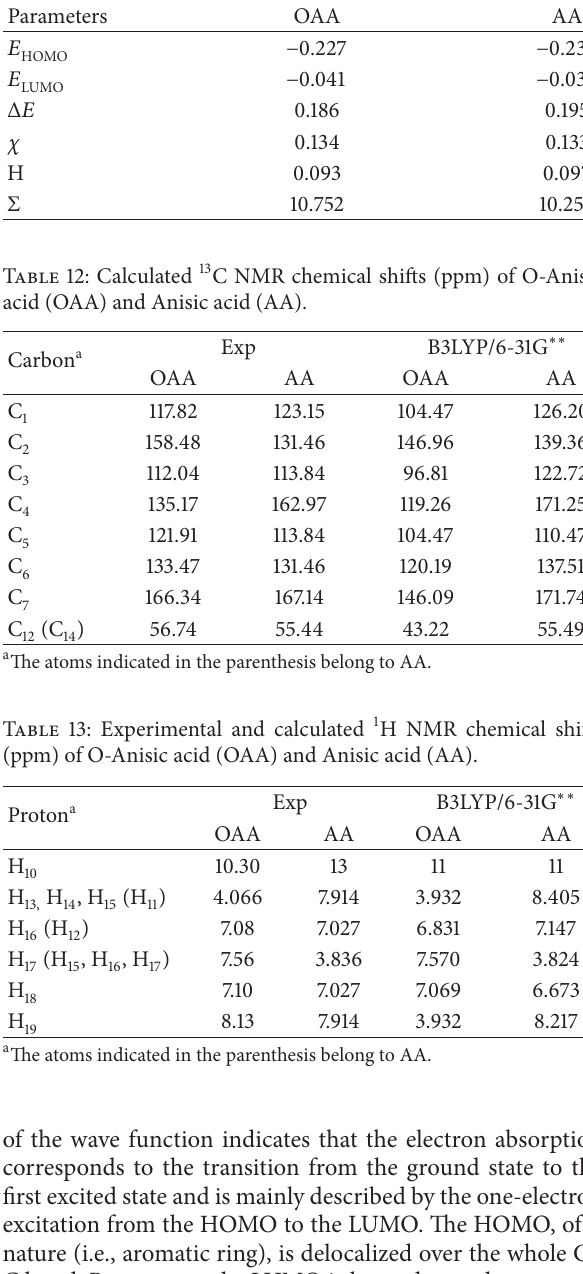
Table 9: Atomic charges for optimized geometry of O-Anisic acid (OAA) and Anisic acid (AA) obtained by B3LYP/6-31G ∗∗ density functional calculations.